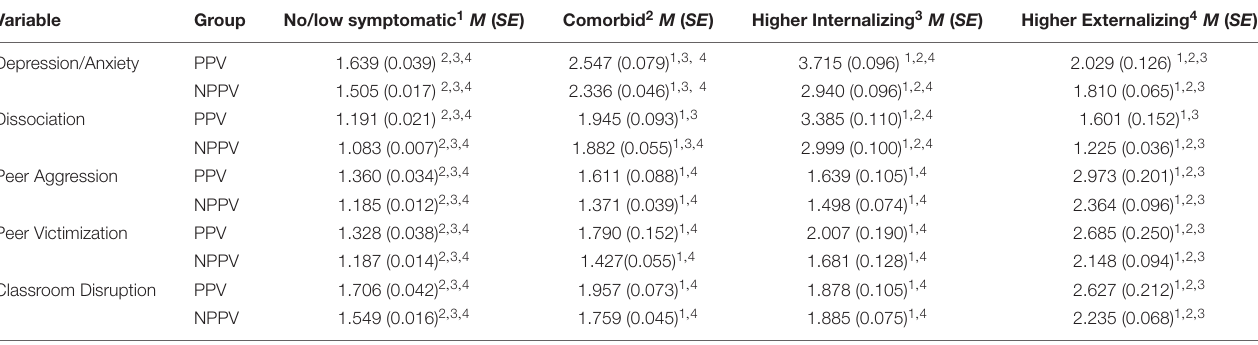
TABLE 4 | Pairwise comparison of the latent profile indicators separately for PPV and NPPV groups.